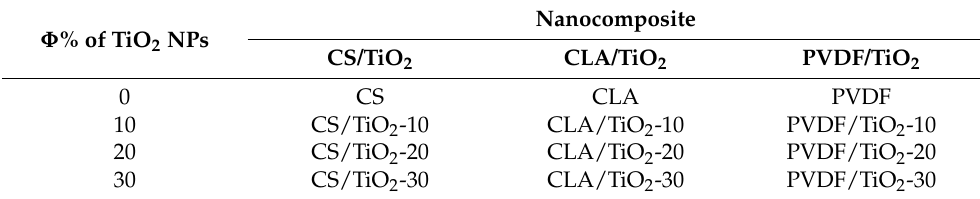
Table 1. Affected names of CS, CLA, and PVDF filled TiO 2 NPs nanocomposites. Φ % of TiO 2 NPs